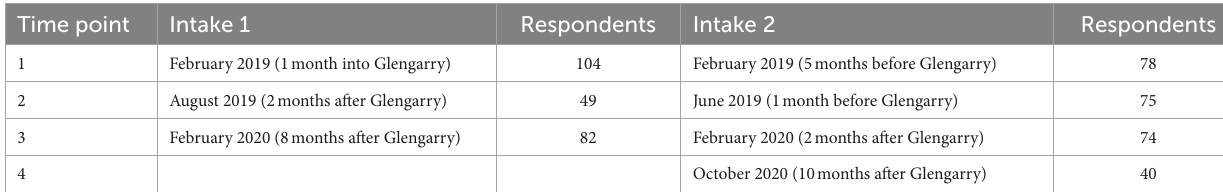
TABLE 1 Quantitative survey administration time points and respondent